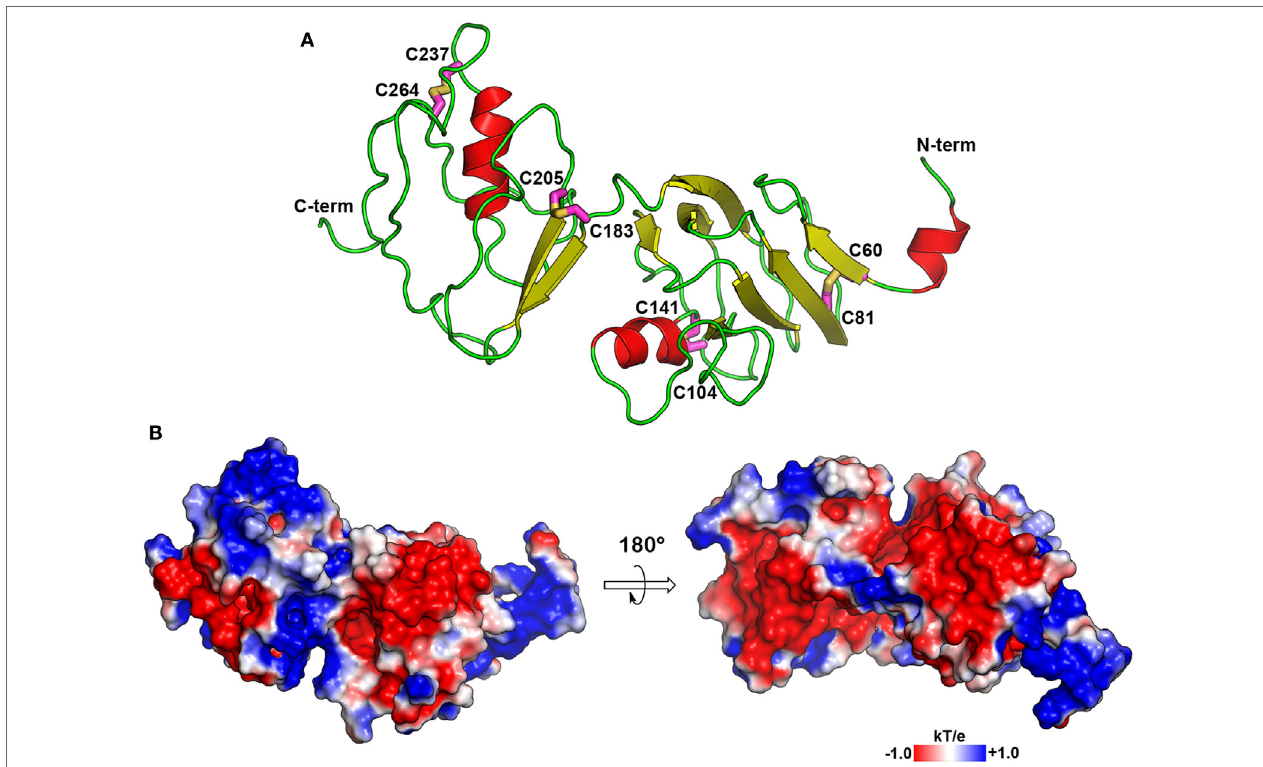
FigUre 1 | Molecular model of CRF-BP. (a) Secondary structure depiction of the obtained folding for human CRF-BP. The residues forming part of disulfide bridges are shown with the carbon atoms in magenta stick representation. (B) Electrostatic potential surface plotted onto the solvent accessible surface ( ± 1 kT/e). The positive and negative electrostatic values are colored in blue and red,